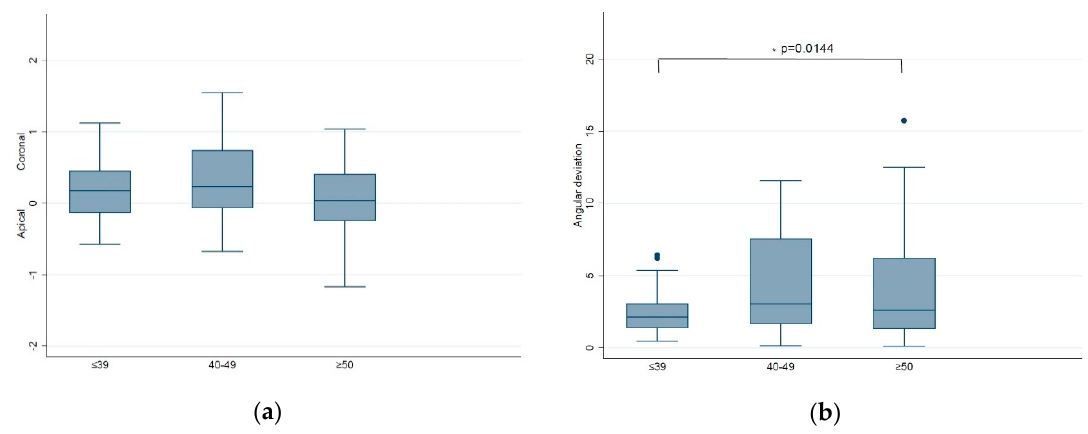
Figure 12. Box plots of the ( a ) depth deviation and ( b ) angular deviation of the three operator age groups.